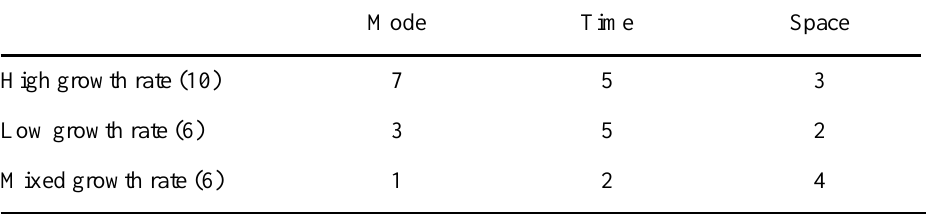
Table 7. Number of groups with explicit discussions on the use of explicit mode, when to start or stop harvesting, and where to